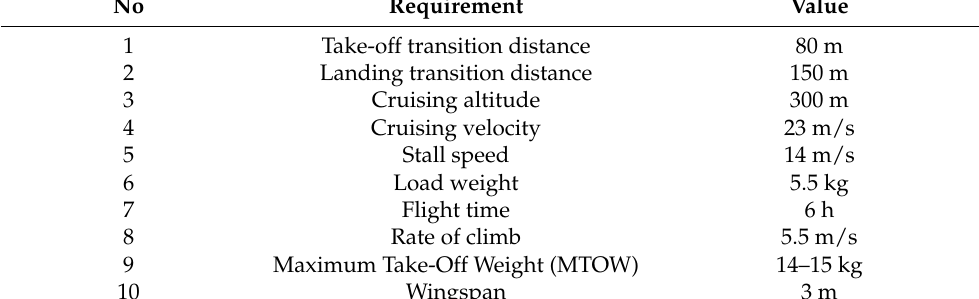
Table 1. Design Requirements and Objective (DRO).